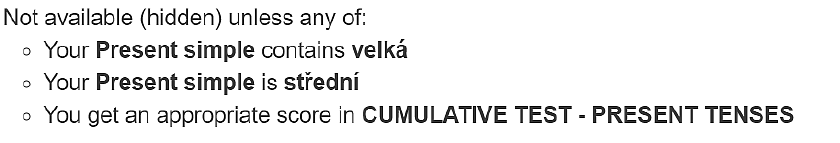
Figure 8. Access restrictions to a lesson.